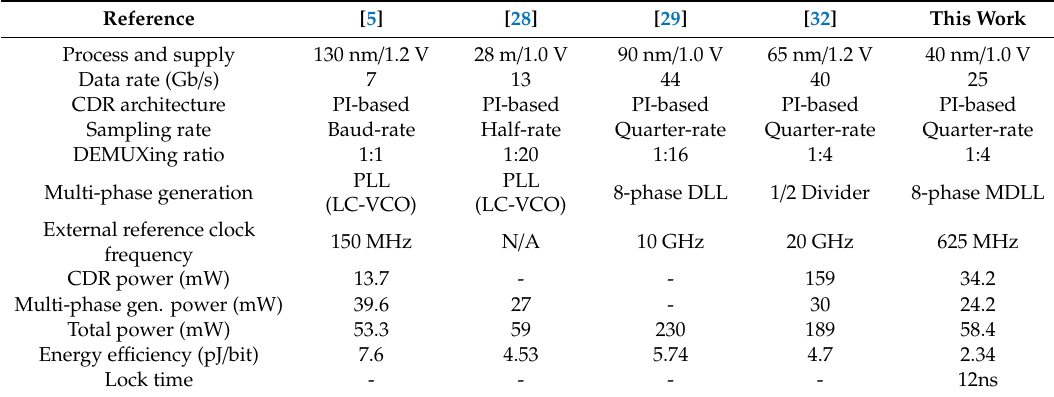
Table 1. CDR performance summary and comparison.